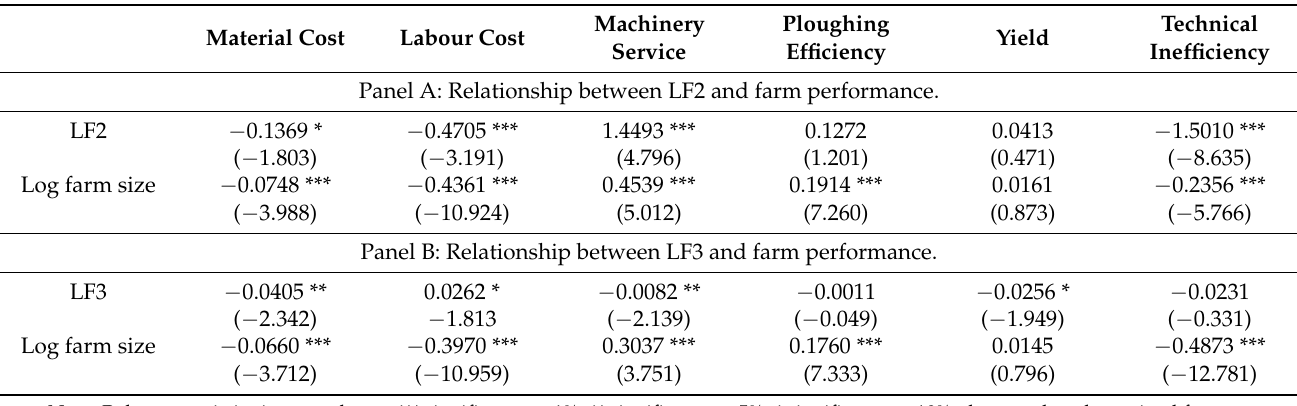
Technical Machinery Ploughing Yield Service Efficiency